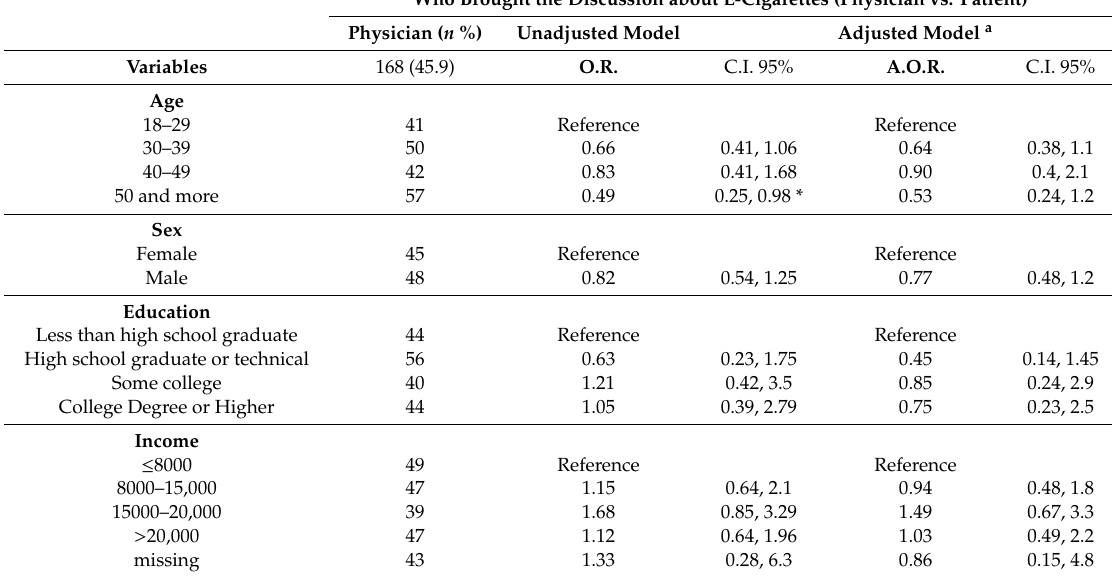
Table 3. Characteristics associated with the physician bringing up electronic cigarettes with adult smokers aged 18 to 71, living in Mexico 2018–2019 ( n =